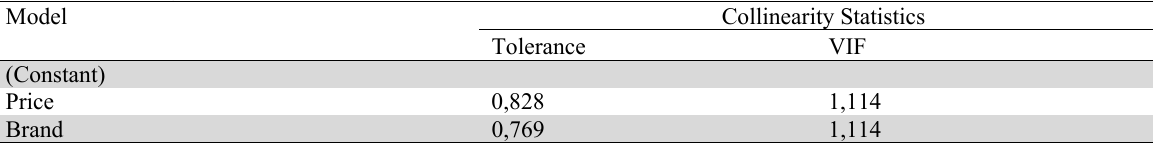
Multicollinearity Test